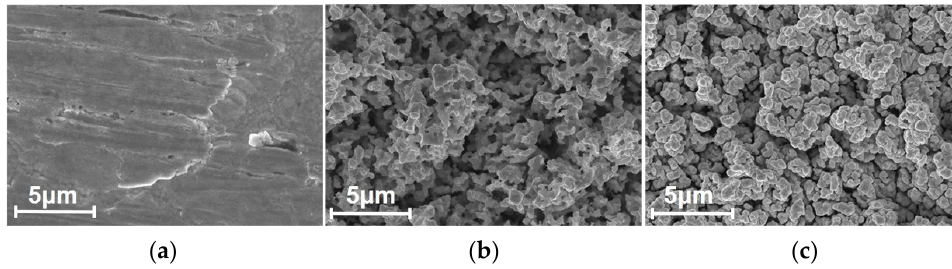
Figure 2. The SEM images of the D4 scheme sample surface throughout experimental process. ( a ) The surface morphology before wet etching. ( b ) The surface morphology after wet etching. ( c ) The surface morphology after gold coating.